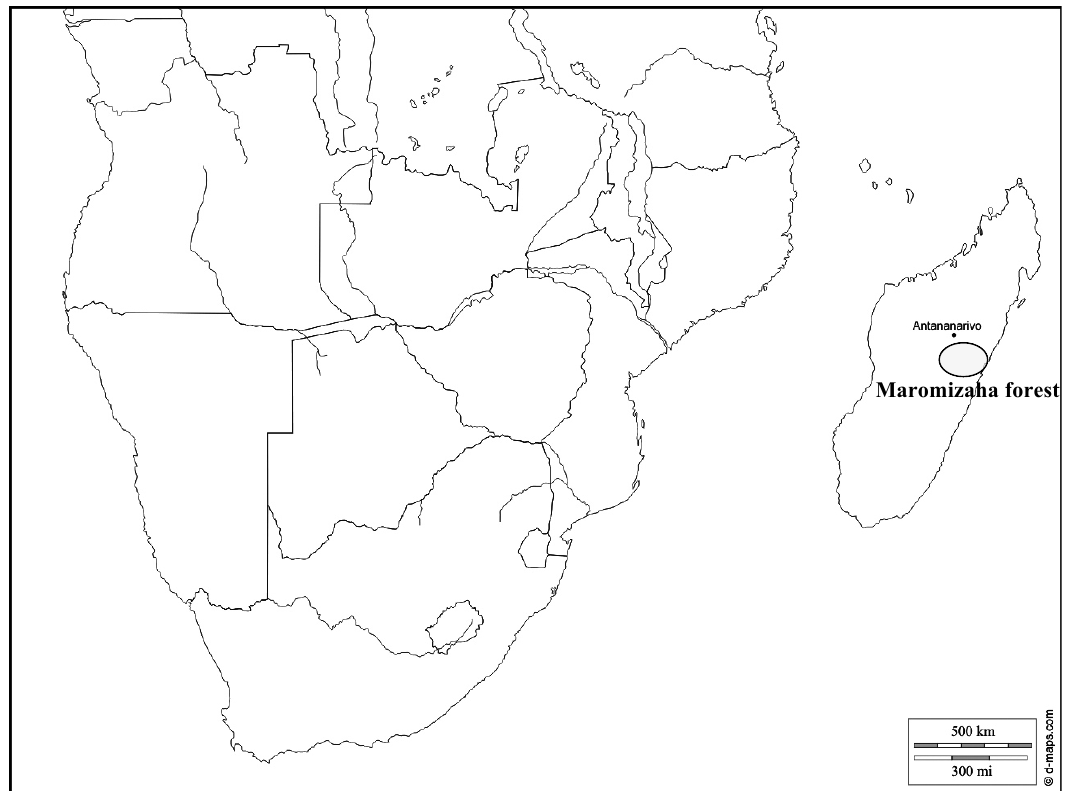
Fig. 1: Geographical location of Brachylaena ramiflora